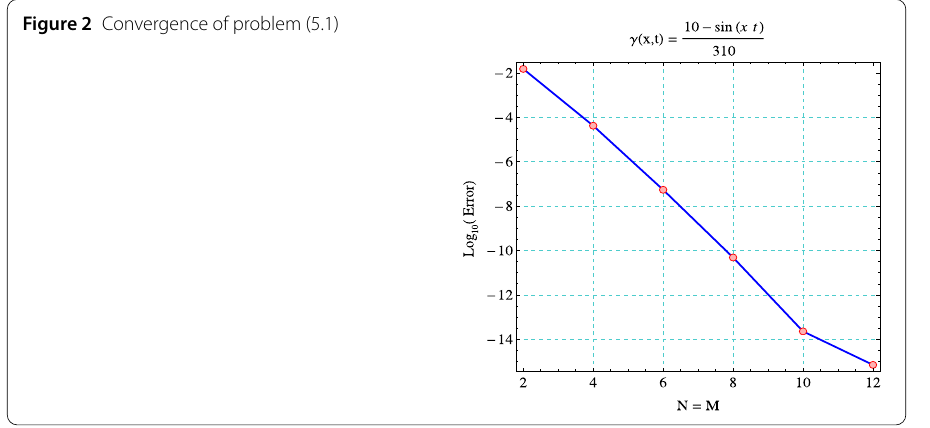
Figure 2 Convergence of problem